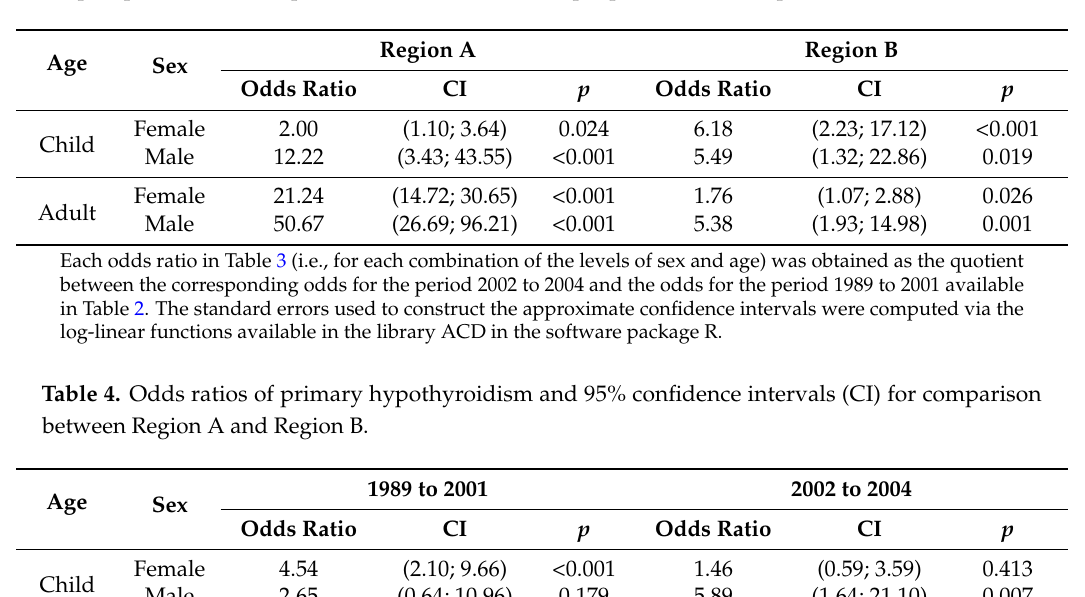
Table 3. Odds ratios of primary hypothyroidism and 95% confidence intervals (CI) for comparison between the post public disclosure period (2002 to 2004) and the pre public disclosure period (1989 to 2001).